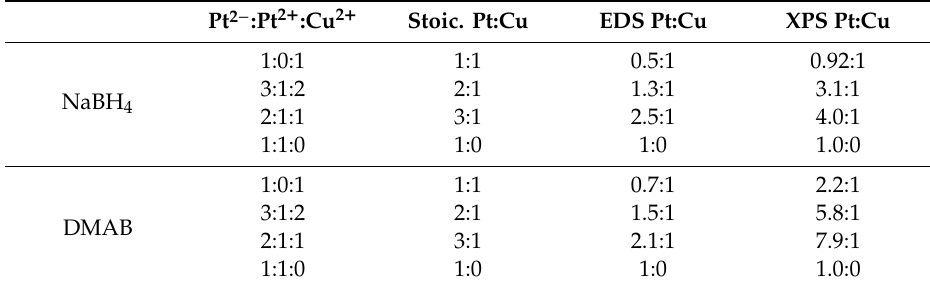
Table 1. Atomic composition of Pt–Cu macrotubes and macrobeams reduced with NaBH 4 and DMAB,